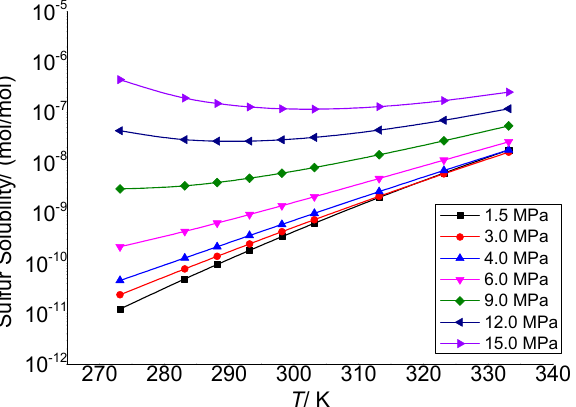
Figure 4. Physical solubility curve of elemental sulfur in acid gas 3 with